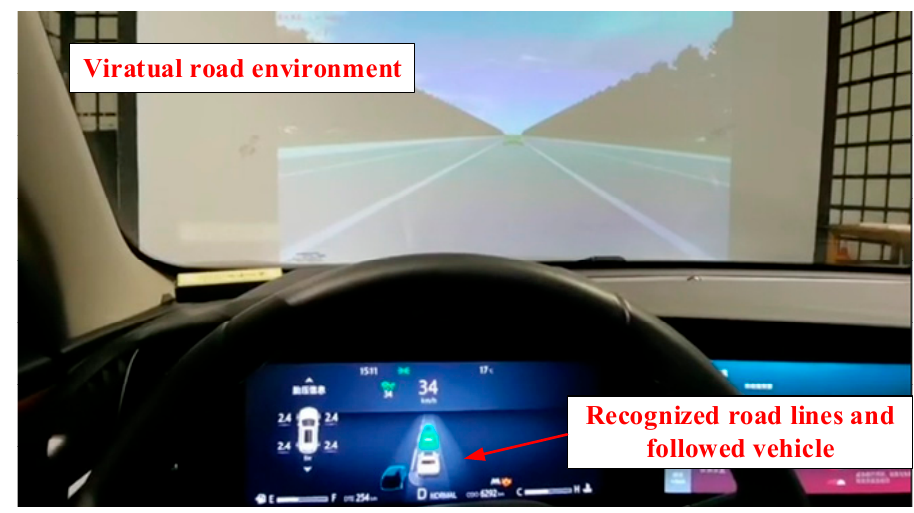
Figure 8. Camera-based LDW and FCW function activation in VUT.